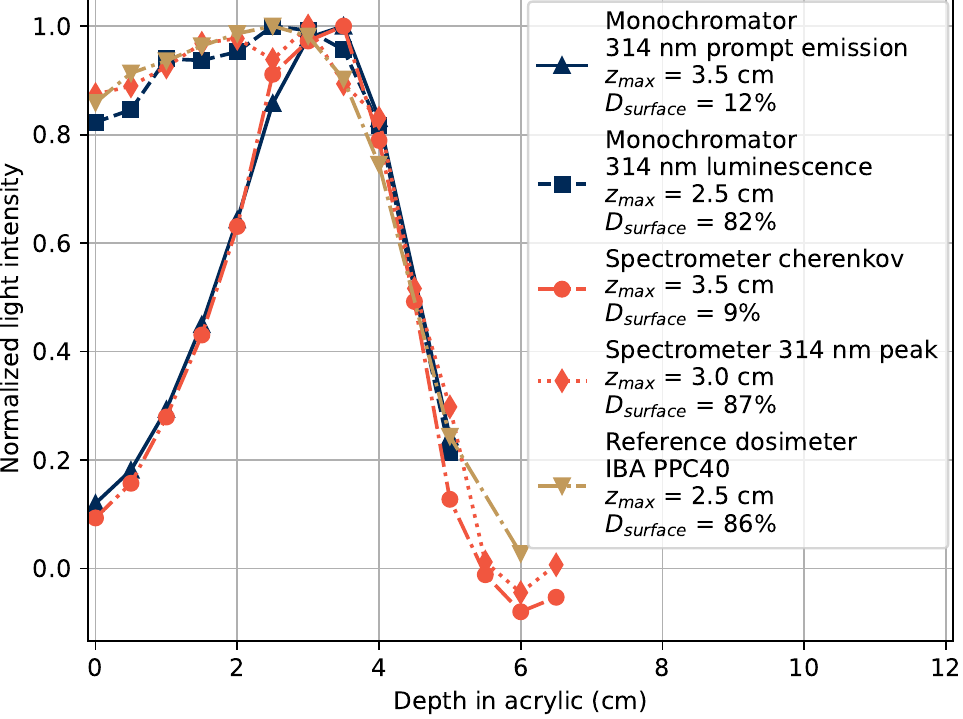
Figure 6. Dose–depth curves in acrylic of 12 MeV electrons obtained with the digitized PMT signal and monochromator set to 314 nm as shown in blue, using optical spectrometer in orange, and IBA PPC40 dosimeter in